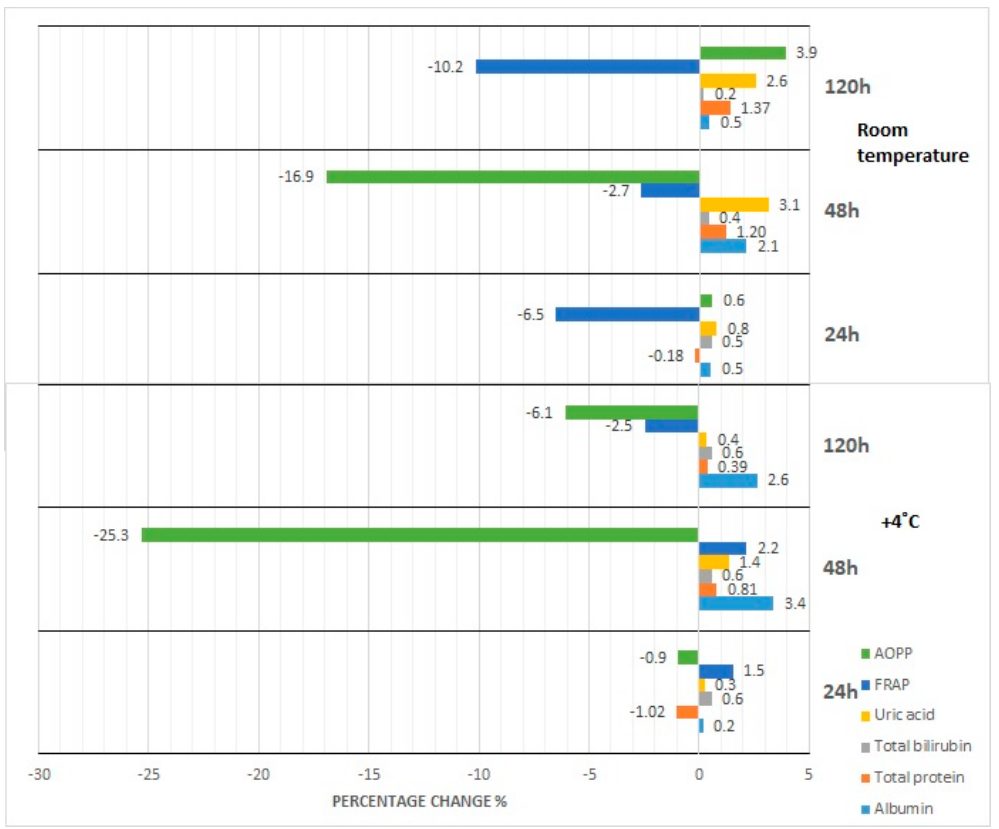
Figure 1. Percentage changes in concentration of selected parameters after storage of serum samples for 24–120 h at room temperature (RT) and 4 °C (fridge temperature, FT), AOPP—advanced oxidation protein products, FRAP—ferric reducing ability of plasma, UA—uric acid, Bil—bilirubin, TP—total protein, Alb—albumin.